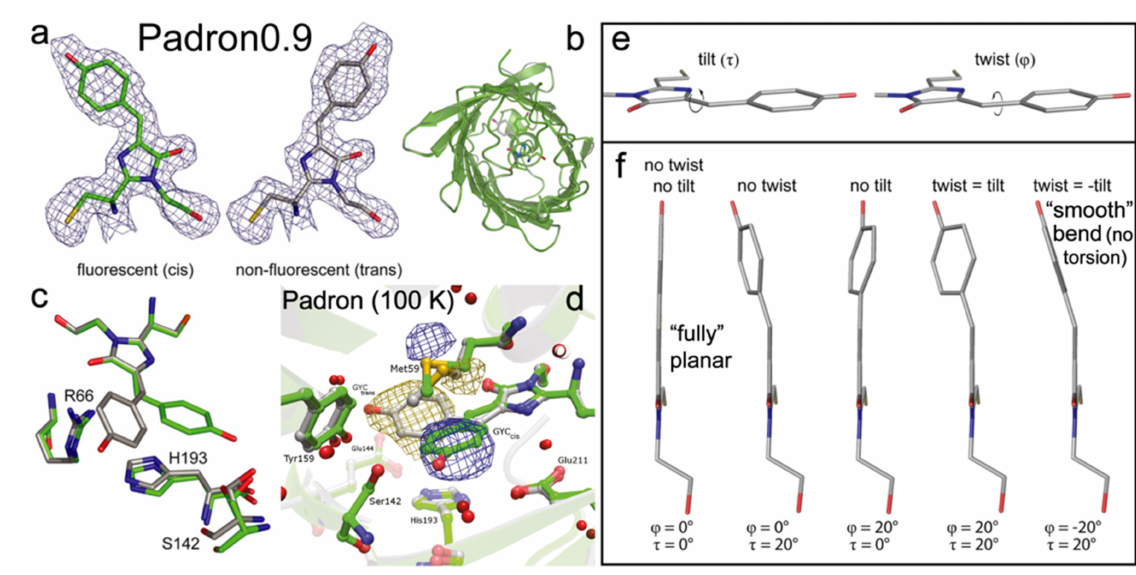
Figure 9. Molecular basis for the positive-switching Padron0.9 and Padron. ( a ) The CYG chromophore of Padron0.9 was determined to be in fluorescent ( cis -) and nonfluorescent ( trans -) states from X-ray crystal structures [35]. ( b ) Aerial view of the protein β -barrel (green) with the embedded chromophore in the center (green, on state; gray, off state). ( c ) No significant rearrangements of the surrounding residues (e.g., R66, S142, H193) occur in the on (green) and off (gray) states despite the chromophore isomerization. ( d ) Padron in low-temperature crystals after 532 nm irradiation at 100 K displays the chromophore isomerization from trans - (off, gray) to cis - (on, green) states with some key residues (e.g., S142, E144, Y159, H193, E211) in the protein matrix showing small rearrangements. ( e ) Illustrative modulus of the sum of two bridge dihedral angles ( τ , close to I ring, tilt; φ , close to P ring, twist) as a measure for two chromophoric ring torsional motions. ( f ) A smooth bend is only achievable when τ and φ values have the same magnitude but opposite signs. Adapted with permission from Ref. [35]. Copyright 2010 The American Society for Biochemistry and Molecular Biology, Inc. Adapted with permission from Ref. [84]. Copyright 2011 American Chemical